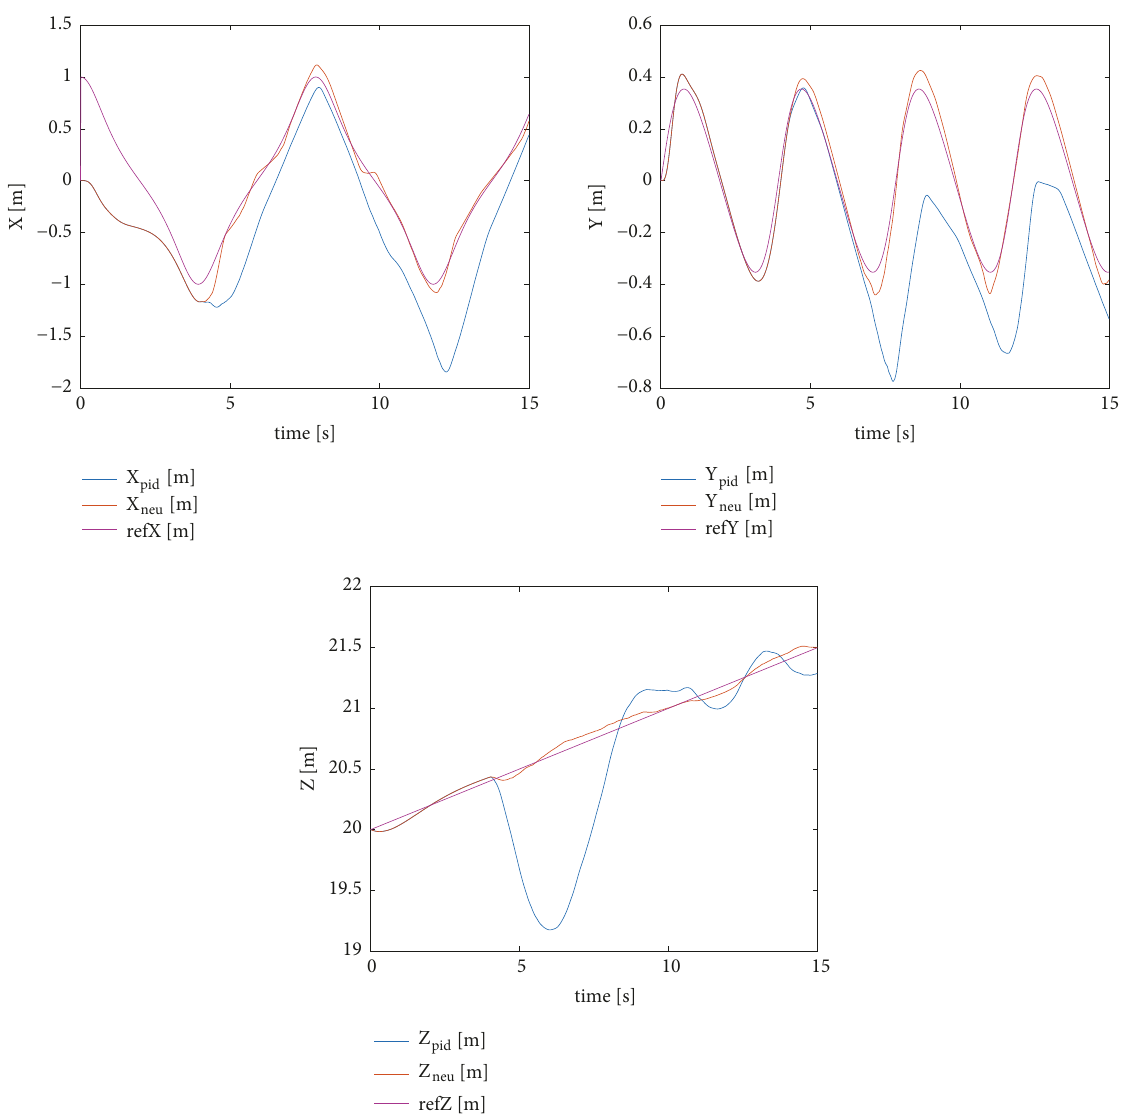
Figure 18: UAV tracking of X, Y, and Z coordinates, respectively, with wind disturbances.